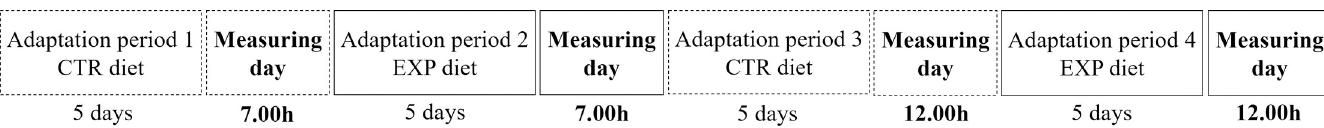
Fig 1. The experimental design for measuring the gastrointestinal myoelectric activity (n = 9 pigs). The diet of measuring days was identical to that of the preceding 5 days of adaptation. CTR: low level of crude fibre (29 g/kg as in feed), soybean- and maize-based feed; EXP: moderate level of crude fibre (49 g/kg as in feed), soybean- and maize-based feed + 4% Opticell (Agromed Austria GmbH, Kremsmu¨nster, Austria).